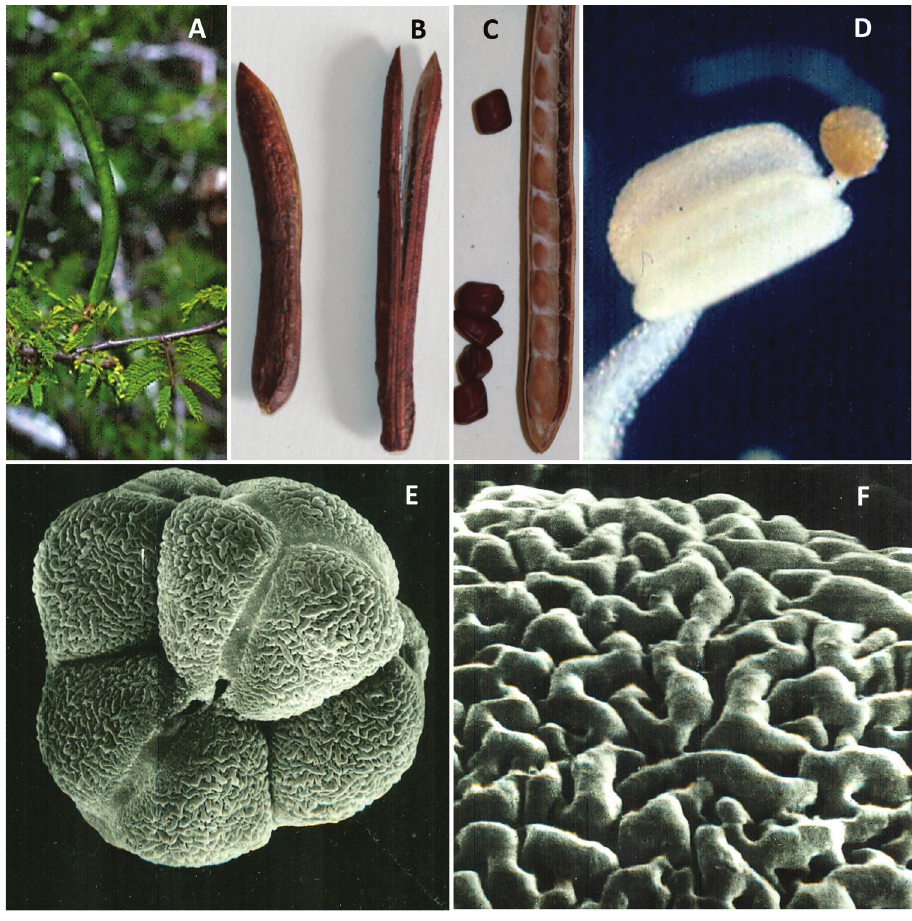
Figure 2. Morphology of Mezcala balsensis A unripe fruits held erect above branchlets B, C ripe fruits, tardily dehiscent from the apex, terete or sub-cylindrical in cross-section with thickened valves, and rhombic, four-angled seeds D claviform anther gland E tetrahedral tetrad of tricolporate pollen grains F exine of pollen showing striate ornamentation. Photos A–C José Luis Contreras Jiménez D Alejandro Martínez Mena,